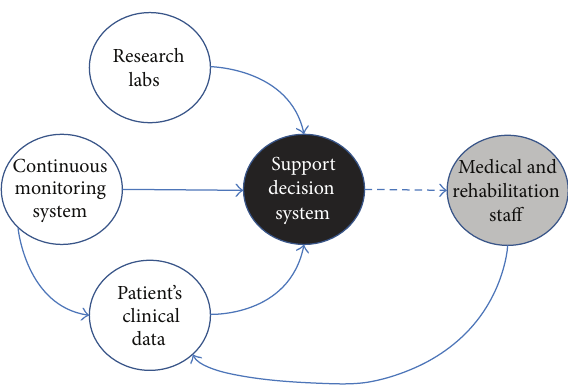
Figure 5: General scheme of the ambient intelligence system now operative at the Institute S.